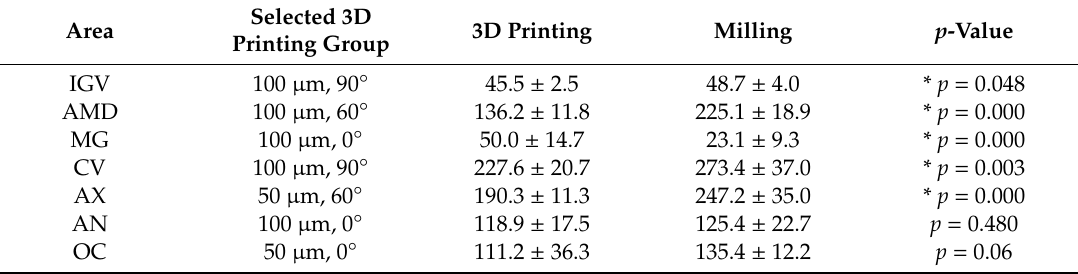
Table 1. The internal gap volume (mm 3 ), marginal fit and internal gap length ( µ m) of the selected 3D printing and milling prosthesis. * indicate statistical significance between 3D printing group and milling